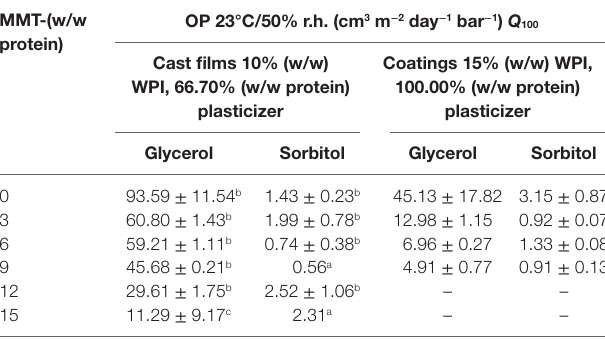
TaBle 2 | Effects of different montmorillonite (MMT) nanofiller-loadings on oxygen permeability ( Q 100 ) of whey protein isolate (WPI)-based nanocomposite cast films and coatings.